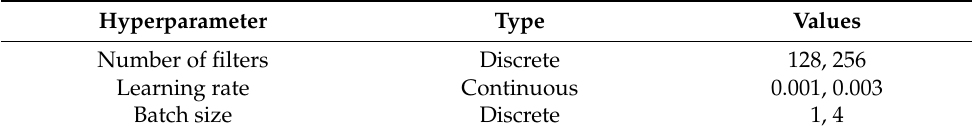
Table 1. Search Space Setup for MSRA3D Dataset.